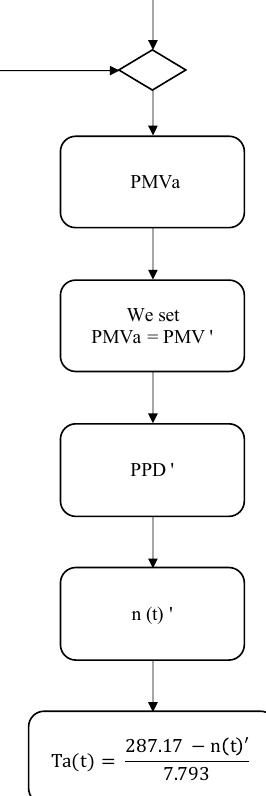
Figure 18. Steps to calculate the adaptive temperature in summer. Table 8. Summary of the PMV, PMV (cid:2911) , PMV (cid:4593) , PPD (cid:4593) , n (cid:4593) (t), and adaptive temperature .